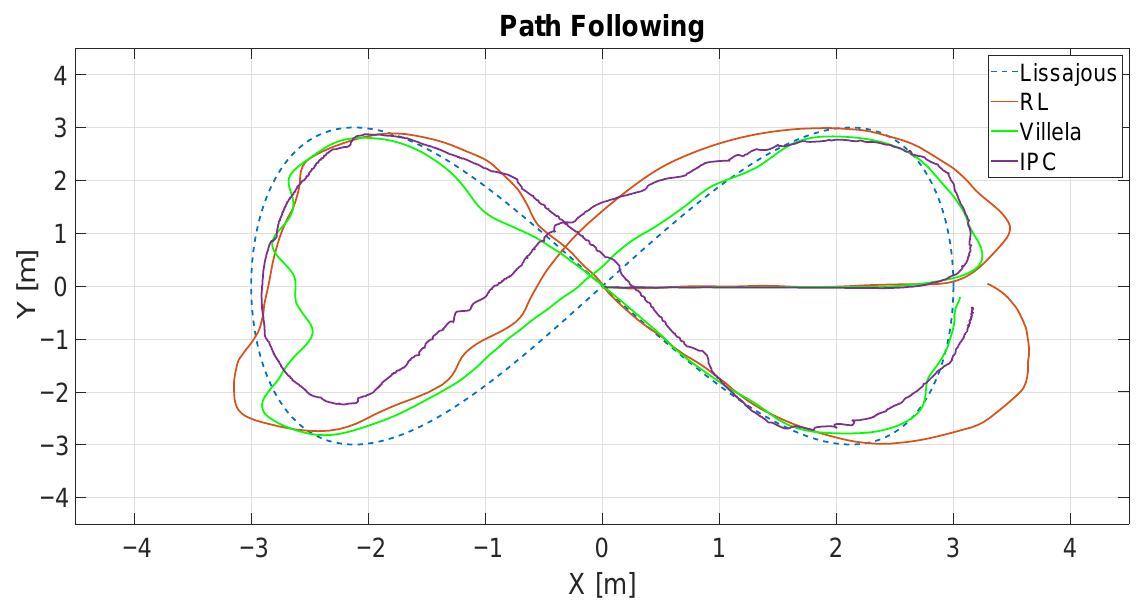
Figure 14. Path following example for Villela, IPC and